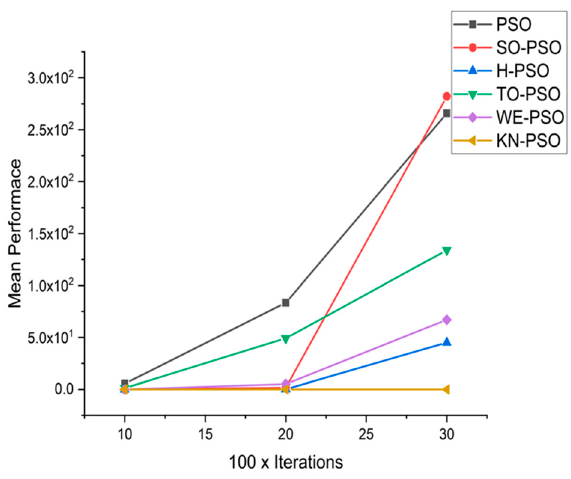
Figure 22. Convergence curve on fn16.